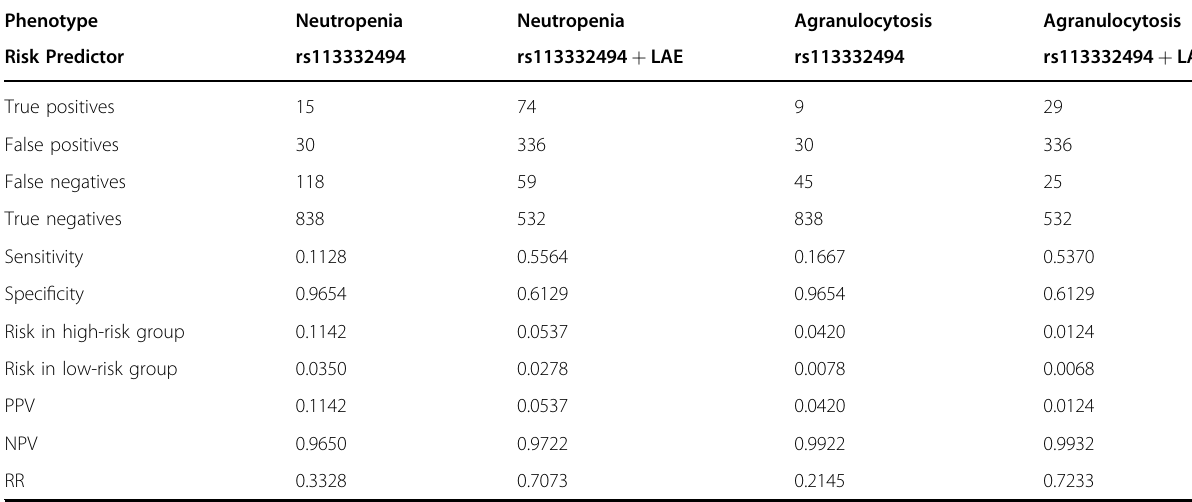
Table 3 Predictive test characteristics of rs113332494 including 868 controls and 133 neutropenia cases (ANC ≤ 1500) of which 54 developed agranulocytosis (ANC ≤ 500).